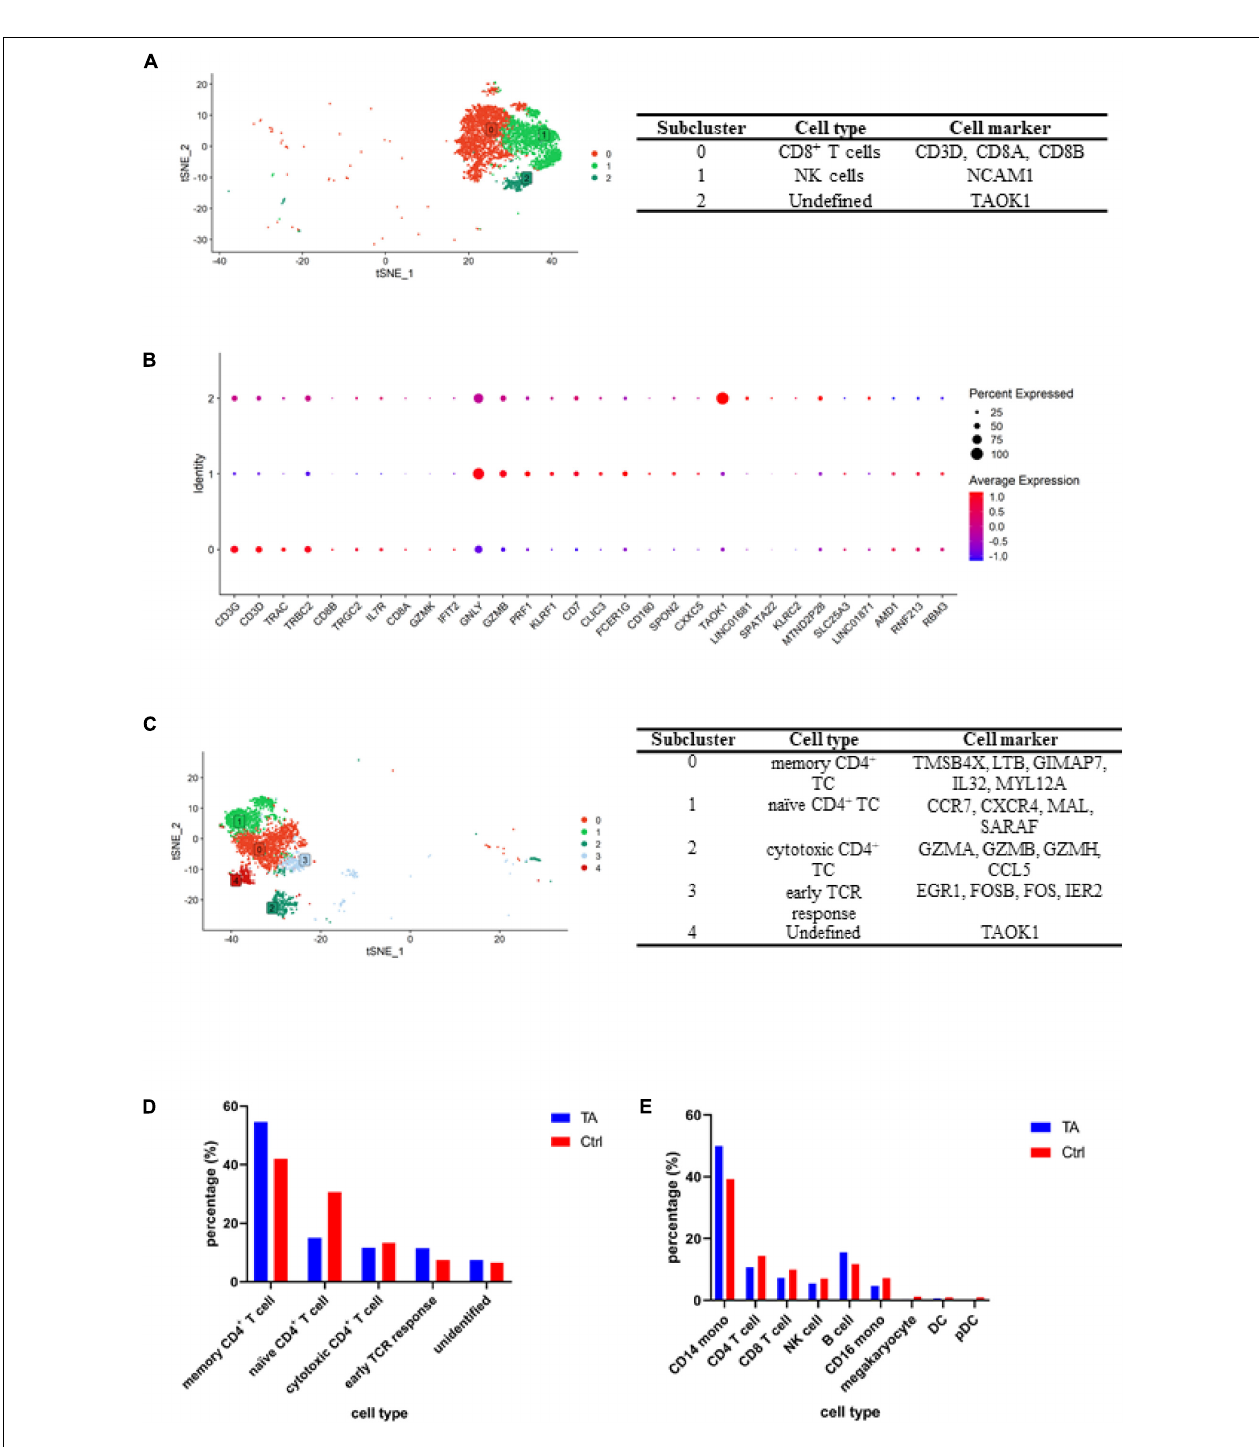
FIGURE 2 | (A) tSNE for CD8 + T/NK cell clusters and representative cell markers for each cluster. (B) Dotplot for CD8 + T/NK cell clusters. To further separate CD8 + T cells and NK cells, we conducted an independent analysis for cluster 1, and according to the expression of specific genes, including CD8A, CD8B, NCAM1 (CD56), we obtained CD8 + T cells (subcluster 0) and NK cells (subcluster 1). (C) tSNE for CD4 + T cell clusters and representative cell markers for each cluster. We verified memory CD4 + T cell (subcluster 0) by TMSB4X, LTB, GIMAP7, IL32, MYL12A; naïve CD4 + T cell (subcluster 1) by CCR7, CXCR4, MAL, SARAF; cytotoxic CD4 + T cell (subcluster 2) by GZMA, GZMB, GZMH, CCL5; early TCR response (subcluster 3) by EGR1, FOSB, FOS, IER2. (D) Comparation of CD4 + T cells composition between TA and Ctrl group. It can be found the percentages of memory CD4 + T cell were higher in TA than Ctrl. (E) Comparation of each cell type percentage between TA and Ctrl group and CD14 + monocyte and B cell were higher in TA than Ctrl.